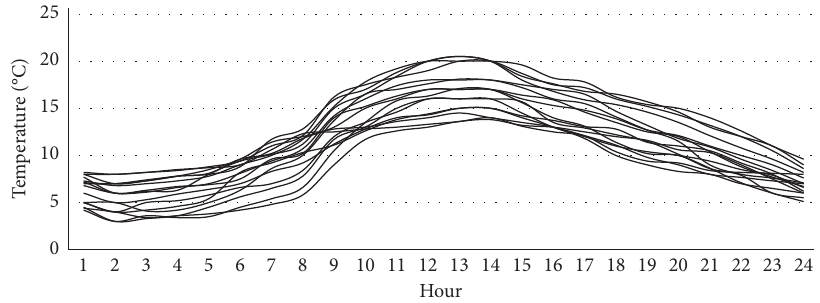
Figure 2: Daily temperatures from the 15 th to 30 th of April, 2014, at Harbin City.